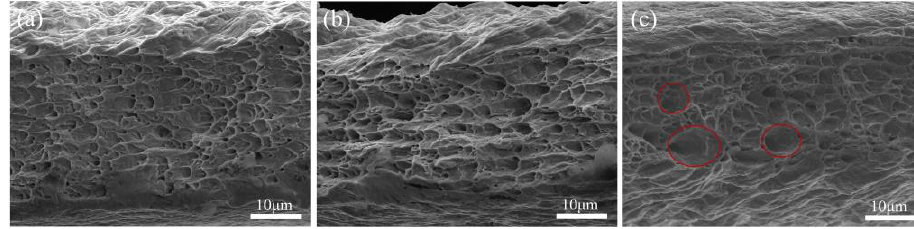
Figure 9. Fracture surfaces of the Gr/Cu composite film at ( a ) 120 s, ( b ) 240 s, and ( c ) 360 s.